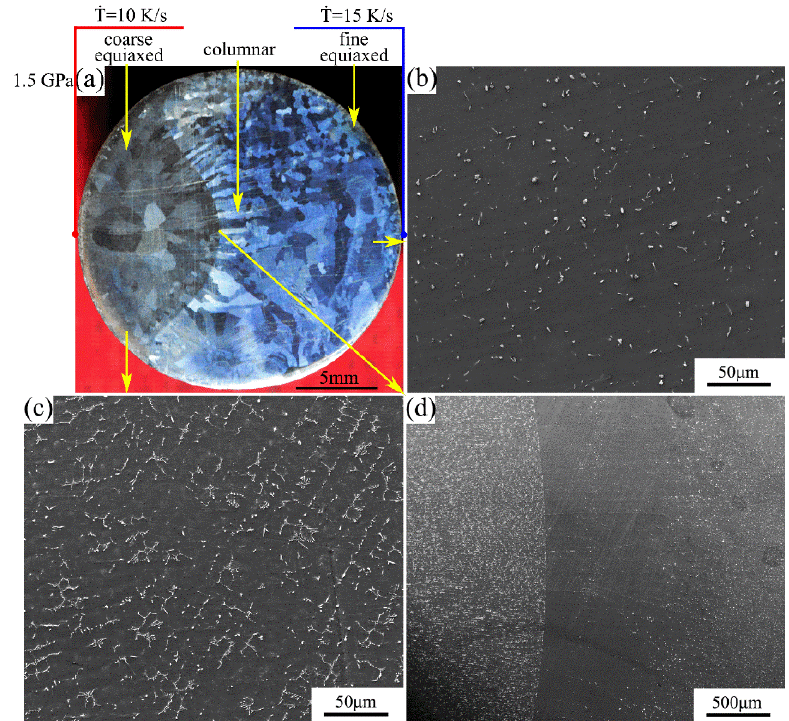
Figure 6. ( a ) Macrostructure and ( b – d ) microstructure of the Mg-1Sn-2.5Y alloy solidified under a pressure of 1.5 GPa: ( b ) outer fine equiaxed zone; ( c ) coarse equiaxed zone; ( d ) columnar-to-equiaxed transition zone.